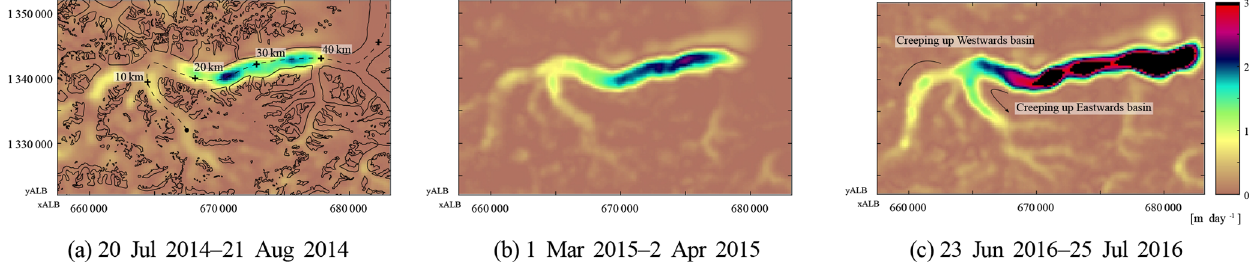
Figure 11. Snapshots of ice speeds at different time instances from a data compilation for the summer 2016 surge occurring on Klutlan Glacier (for location see Fig. 7). The used GoLIVE data configuration is shown in Fig. A1, and the data are from the smoothed dataset.